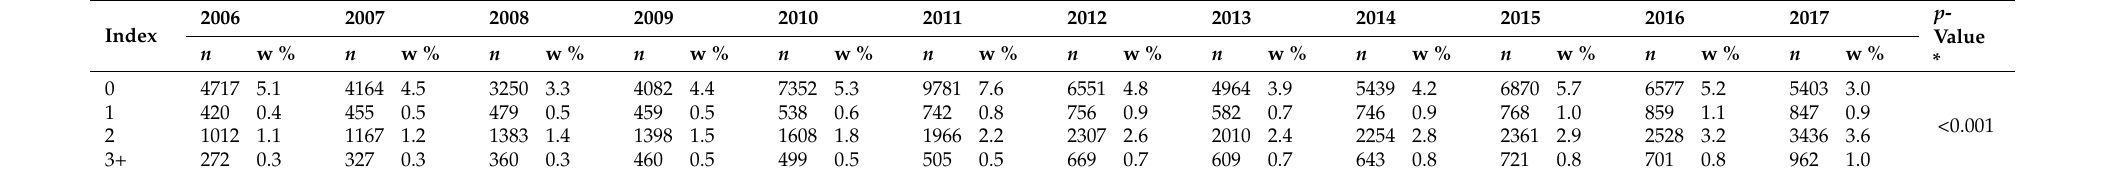
Table 4. Comorbidity index of discharged pneumonia patients in each